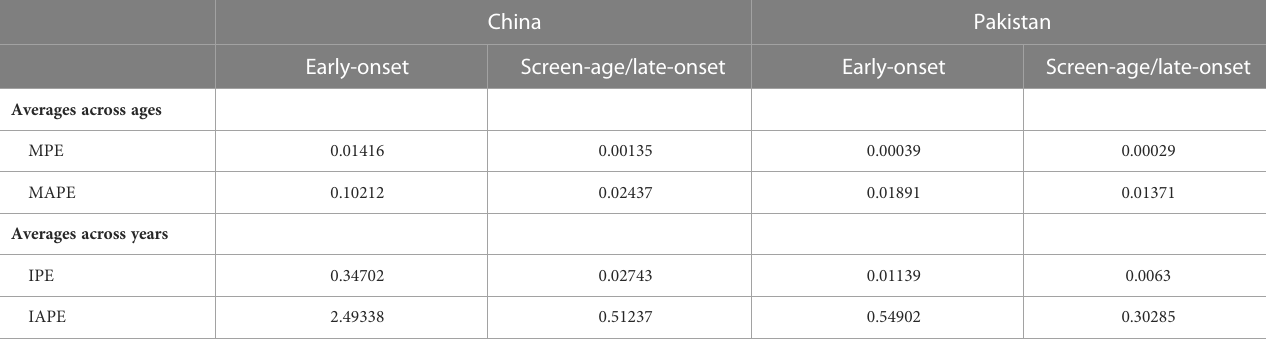
TABLE 1 Error measures from fi tted Lee – Carter model of the early-onset and screen-age/late-onset breast cancer population for China and Pakistan.